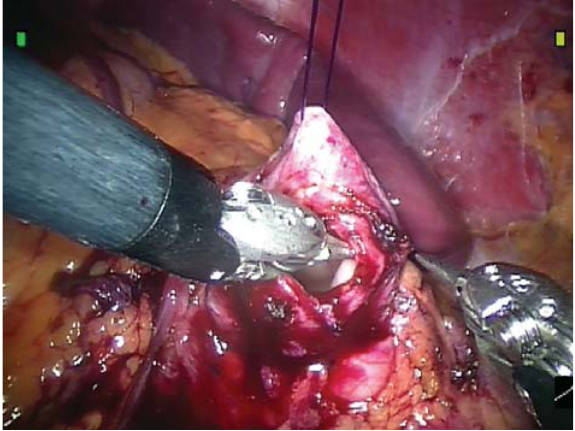
Figure 2 – Renal pelvis hitch stitch to facilitate exposure and anastomosis with the